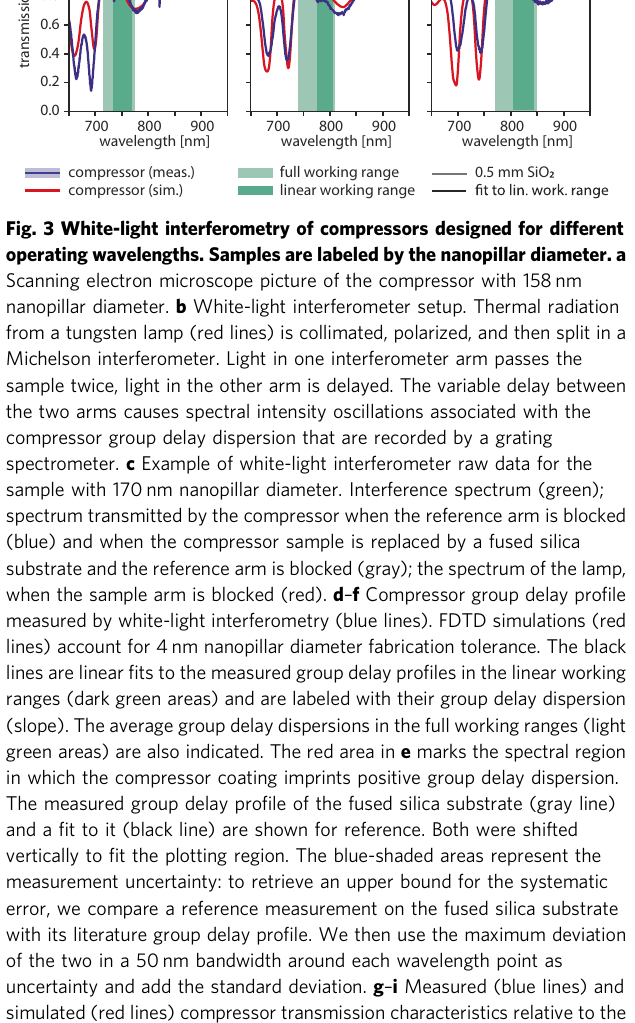
amorphous silicon layer on a 0.5 mm-thick fused silica substrate (see methods), Fig. 3a shows a sample imaged using scanning electron microscopy.